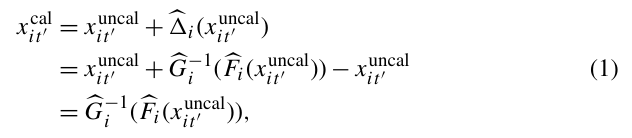
drawn from the same it (cid:48)